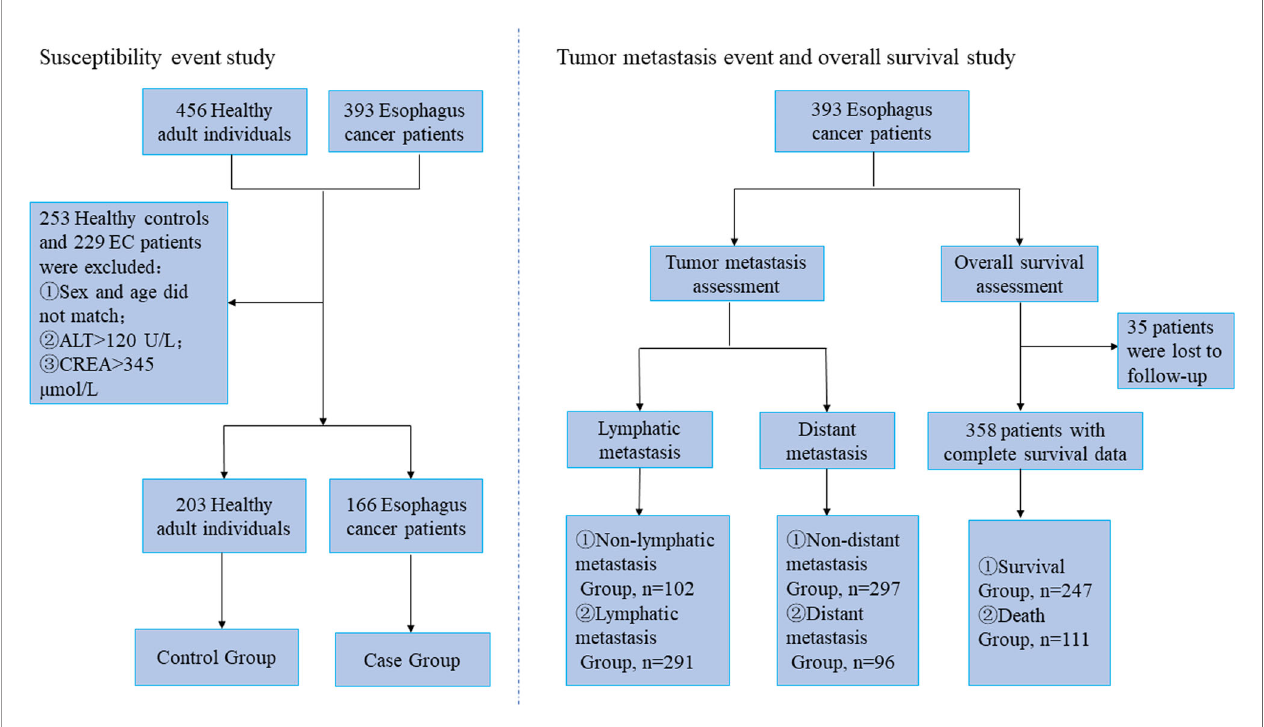
FIGURE 2 | Flow chart of experiment design and sample